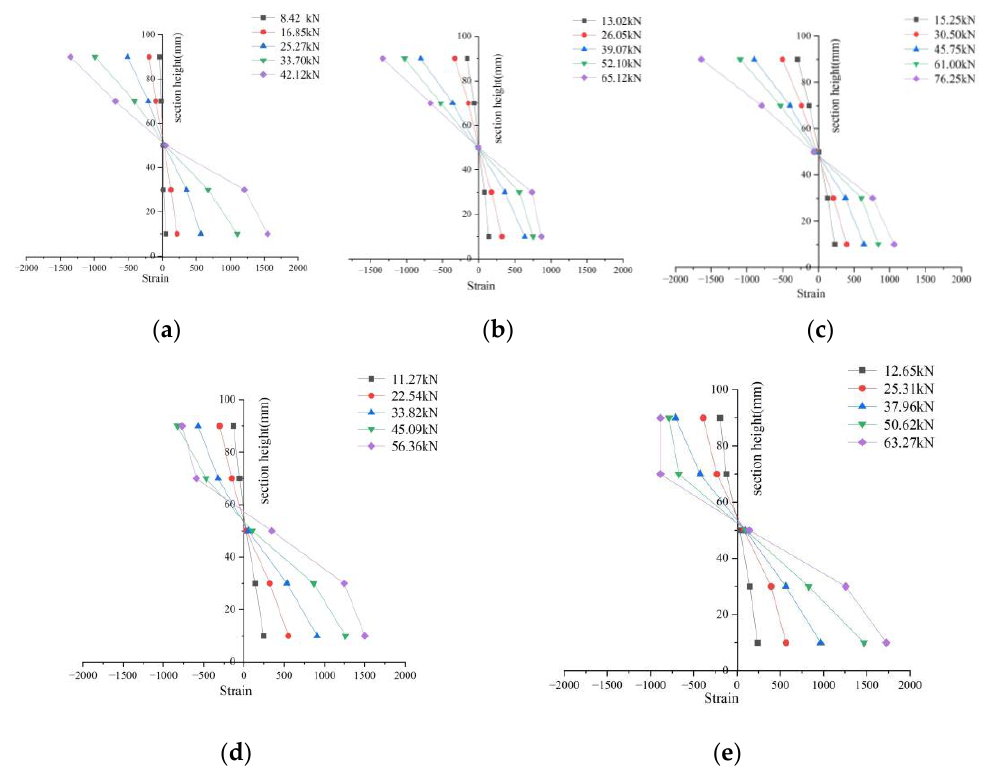
Figure 23. Strain curves of single-span section of beams under various working conditions. ( a ) beam LA1; ( b ) beam LA2/LB2; ( c ) beam LA3; ( d ) beam LB1; ( e ) beam LB3.